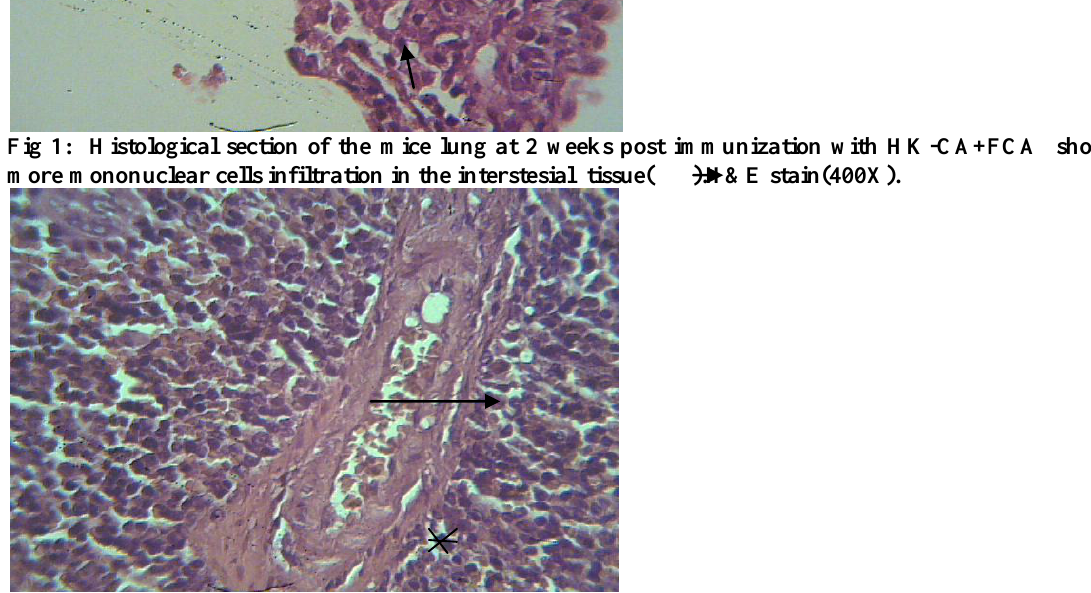
Fig 2: Histological section of the mice spleen at 2 weeks post immunization with HK-CA+FCA showed more intensive hyperplasia of lymphocytic cells in the periarteriolar sheath.( )with hyper- trophy of muscular layer of central artery(*),also the microscopic section showed mononuclear cells aggregation arround the central artery.H&E stain(400X).